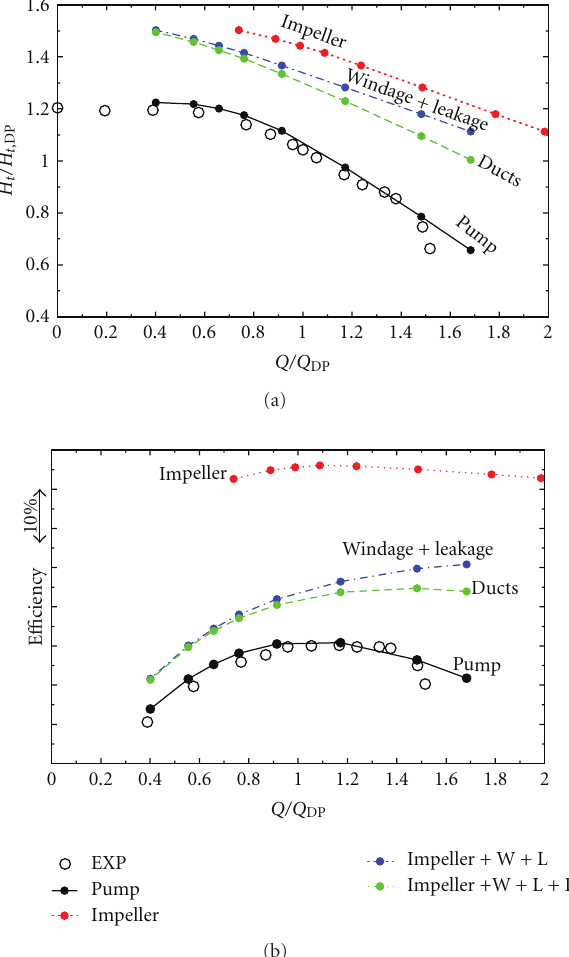
Figure 7: Comparison between predicted and measured pump characteristics ( N s = 10 . 9).